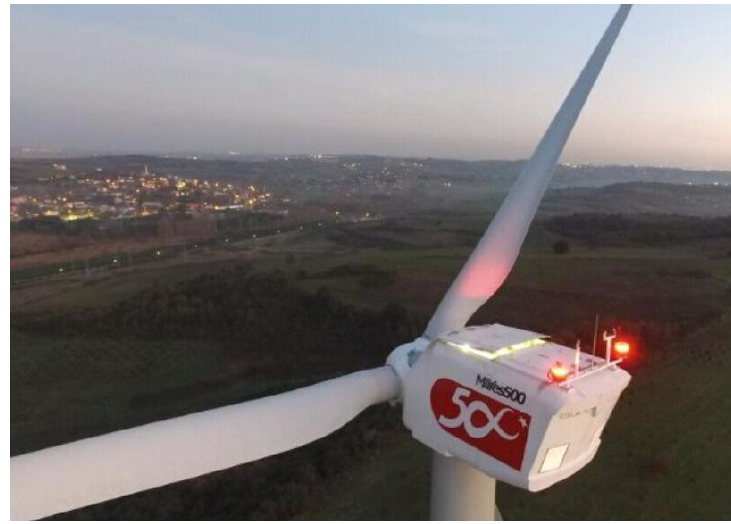
Figure 2. Completed implementation of the wind turbine.